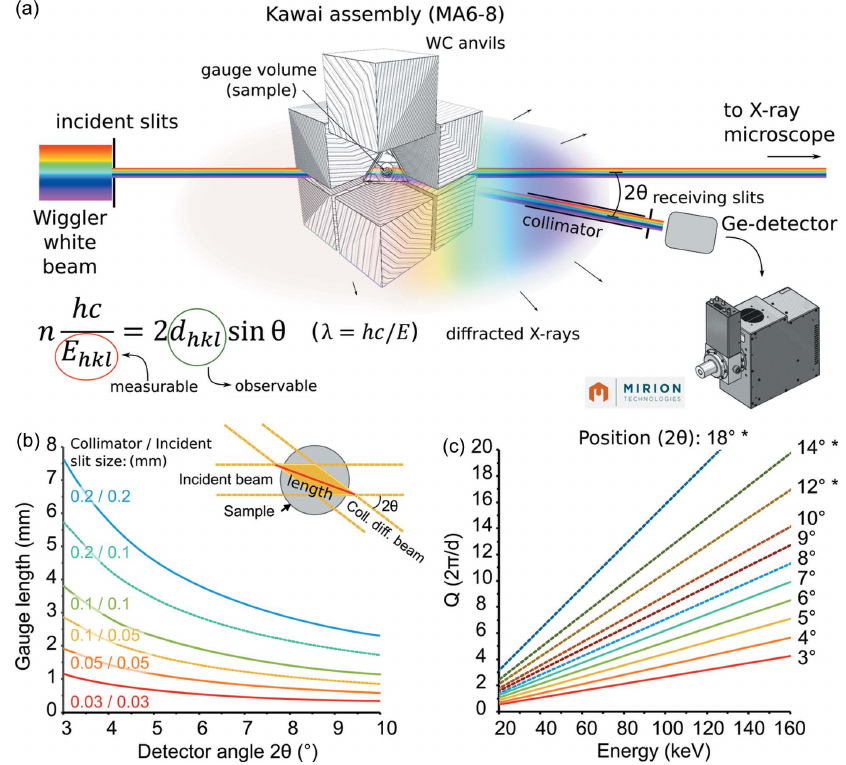
Figure 7 ( a ) Schematic of the principle of ED-XRD based on Bragg’s law for a sample inside an octahedral assembly surrounded by eight WC anvils. ( b ) Calculation of the gauge length ( i.e. the red line labelled ‘length’) as a function of detector angle position (2 (cid:6) ), incident beam and collimated beam size. ( c ) Calculation of the scattering vector Q (A˚ (cid:4) 1 ) as a function of energy (in the case of ED-XRD) and 2 (cid:6) (the detector position). The solid lines indicate typically used detector positions and the available Q range for these positions up to 160 keV. An asterisk (*) indicates these positions can only be obtained using one Ge-SSD and the LVP pre-rotated to increase the access